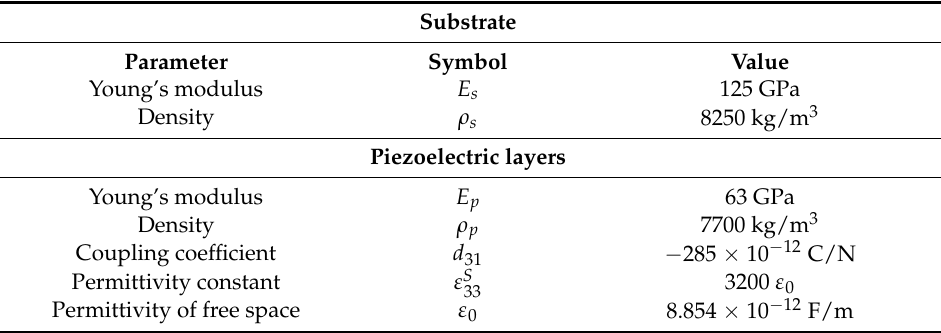
Table 2. Material property